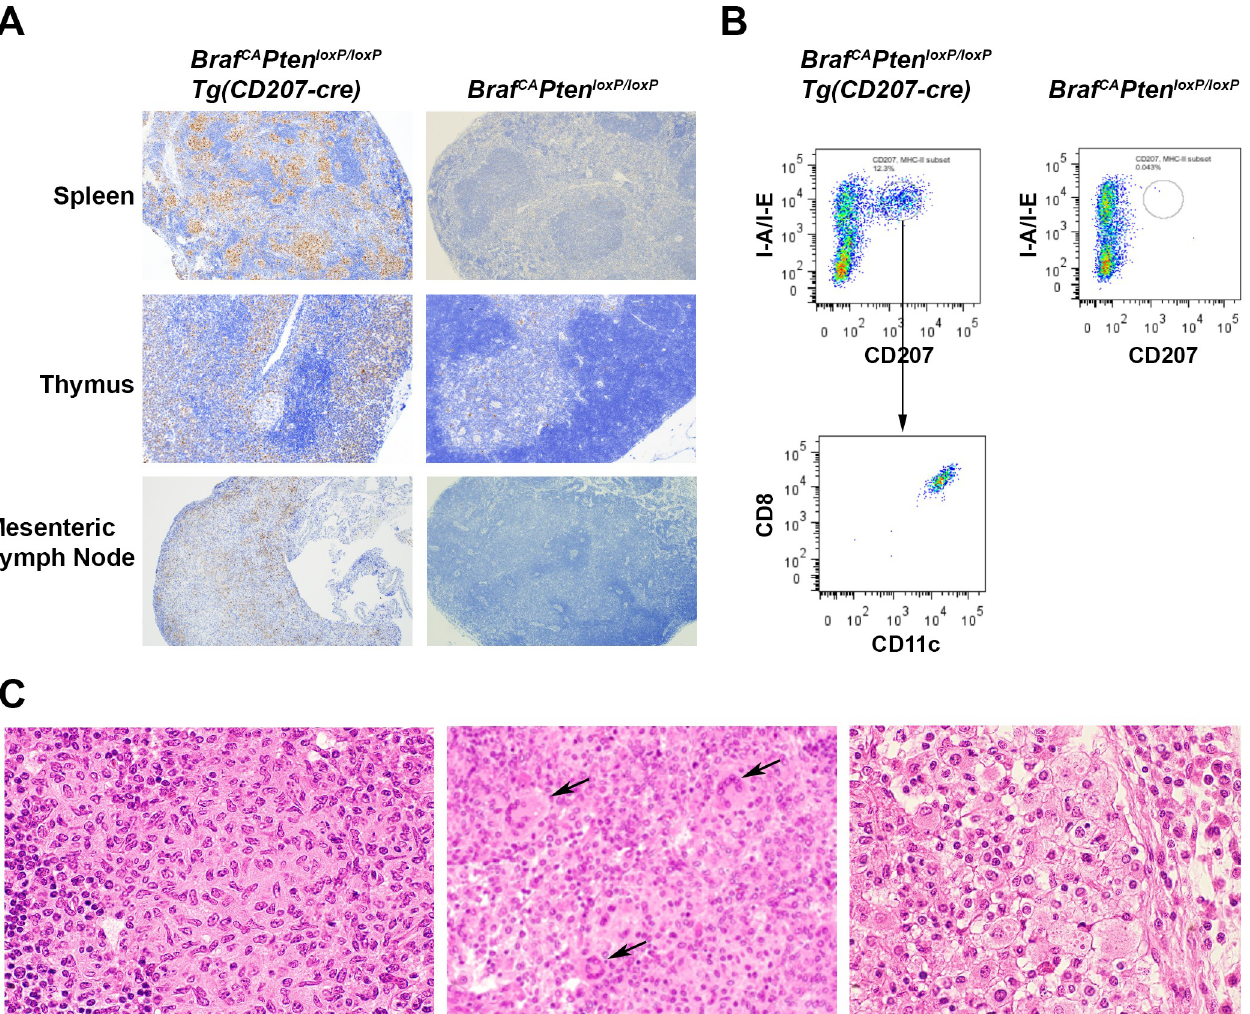
Fig 15. CD207 + histiocytes infiltrating the spleen,thymus,andlymph nodes of Braf CA Pten loxP/loxP Tg(CD207-cre) mice.A. Representative tissue sections from the spleen,thymus,and mesenteric lymphnodes of 36 day old Braf CA Pten loxP/loxP Tg(CD207-cre) and Braf CA Pten loxP/loxP mice wereanalyzed for CD207-expressing cells byimmunohistochemistry.CD207 + cellsare seen infiltrating allthreeorgansfrom Braf CA Pten loxP/loxP Tg(CD207-cre) but not Braf CA Pten loxP/loxP mice.Original magnification, 40X. B. Spleencellswere sortedfor I-A/I-E and CD207expression. Doublepositive cellswere presentin the spleensof 28 dayold Braf CA Pten loxP/loxP Tg (CD207-cre) but not Braf CA Pten loxP/loxP Tg(CD207-cre) mice. Thesecells werethen analyzed for CD8 andCD11c expressionand werefoundto co-expressboth markers. C. Hematoxylin andeosin stainingof threeregionsof a mesentericlymph nodefrom a female Braf CA Pten loxP/loxP Tg(CD207-cre) 32 dayoldmouse showing histiocytic infiltration. Left, histiocyticcells showingfolded nucleiand abundanteosinophiliccytoplasmsimilartothose seen in humanLCH cell; middle, region showinga similarhistiocyticinfiltrate butaccompaniedby multinucleated giant cells (arrows); right, regionshowing a histiocytic infiltrateconsistingpredominantly of foamy histiocytes similarto thoseseen in Erdheim-Chester disease.Originalmagnifications, 100X.